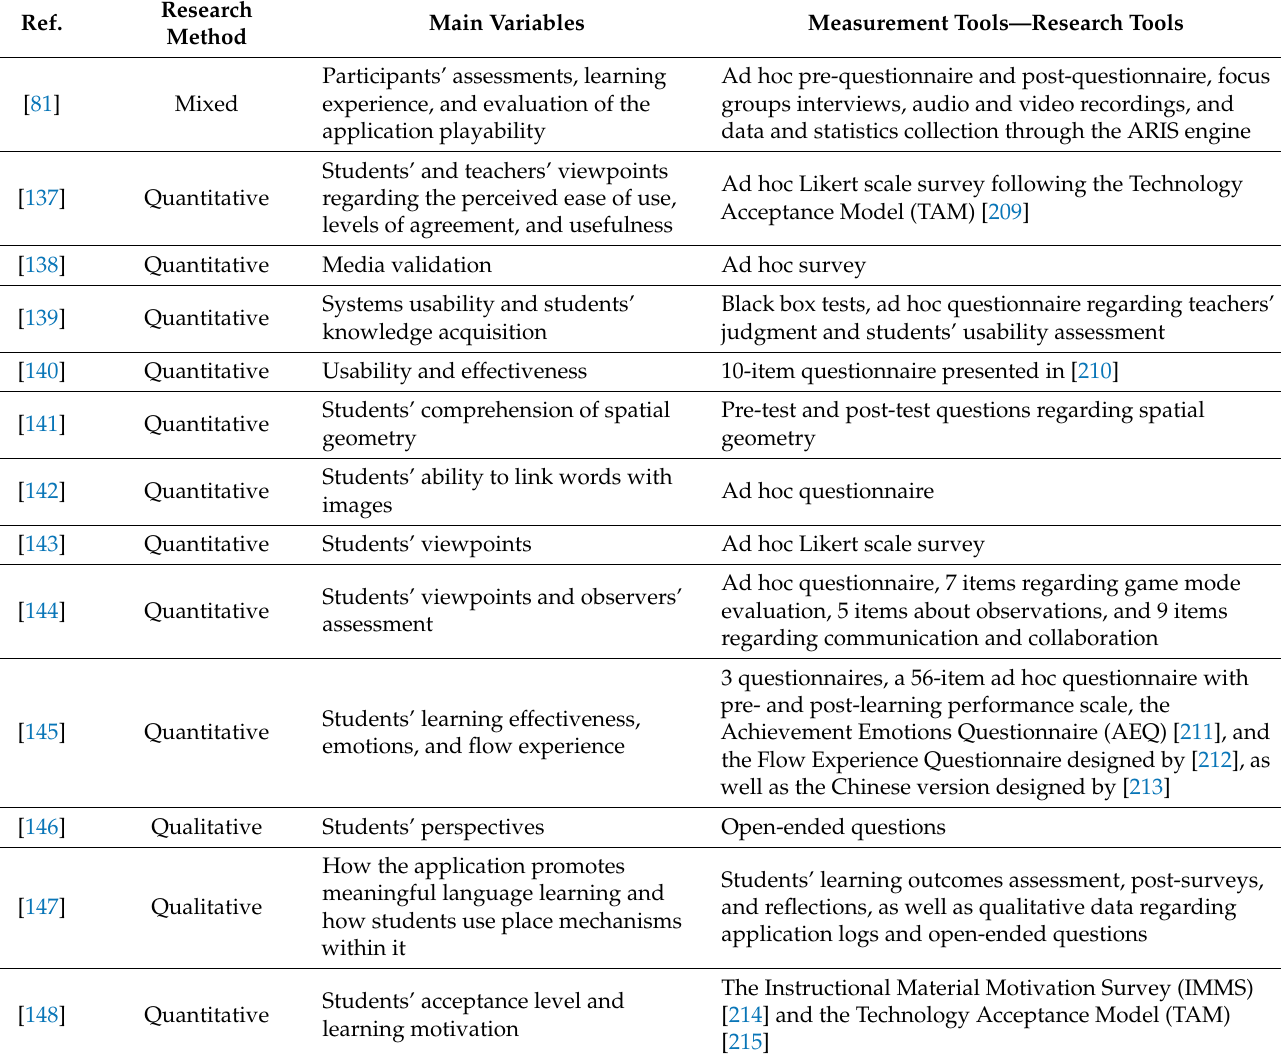
Table 2. Empirical studies: research methods, variables, and